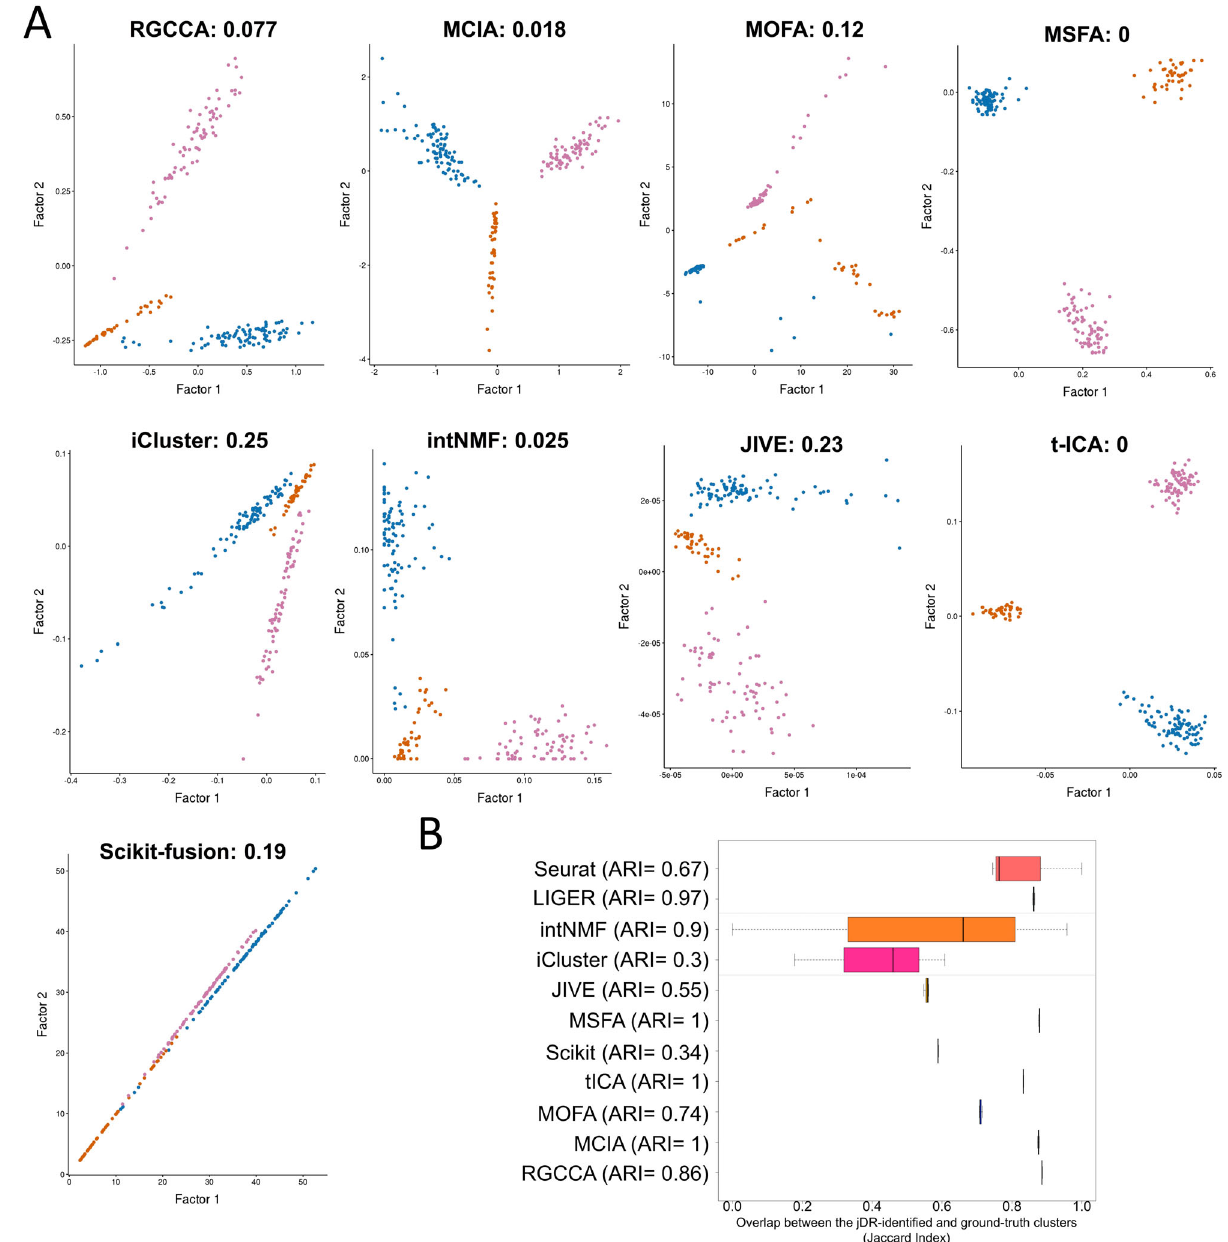
Fig. 7 jDR clustering of single-cell multiomics according to the cancer cell line of origin. a Scatterplots of factor 1 and 2 (i.e., the fi rst two columns of the factor matrix) are reported for each jDR method. The colors denote the cancer cell line of origin: pink for K562, orange for Hela and blue for HCT. The C- index (in the range [0 – 1]) reports the quality of the obtained clusters (0 being the best). b Boxplots of the Jaccard Index corresponding to the application of jDR plus LIGER and Seurat for single-cell multiomics clustering. The corresponding Adjusted Rand Index (ARI) values are further reported near to the name of the jDR methods along the x -axis. The number of cells here considered is 206 and the results are obtained over 1000 independent runs of k-means clustering. Data are presented as mean values ± sd, whiskers denote max, and min